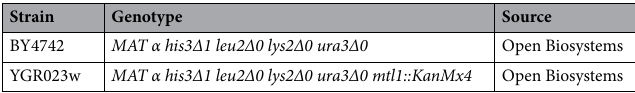
Table 1. Saccharomyces cerevisiae